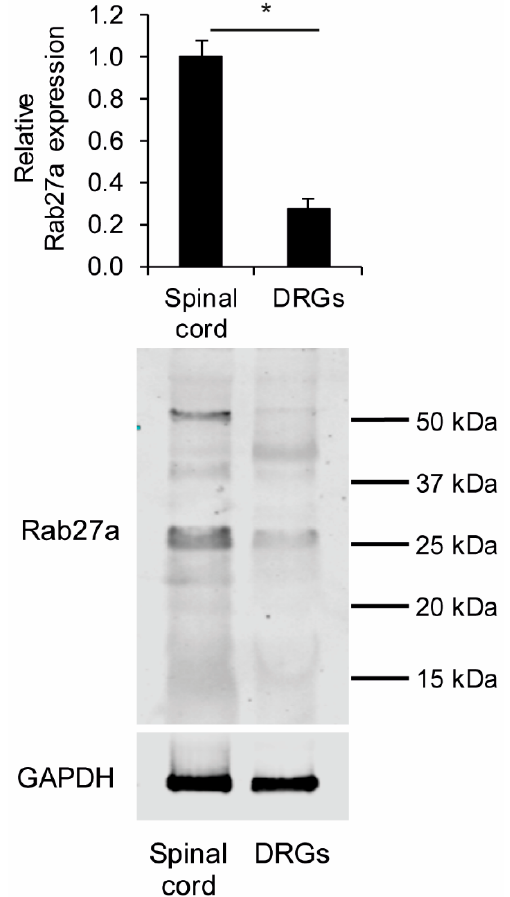
Figure 1. Western blot of Rab27a in the spinal cord and dorsal root ganglia (DRGs) of naive wild type (WT) mice. Rab27a expression at the expected size of 25–27 kDa is significantly stronger in the spinal cord compared to DRGs ( n = 4), * p < 0.001. Some additional bands around 40–50 kDa were also detected, which seem to be unspecific.